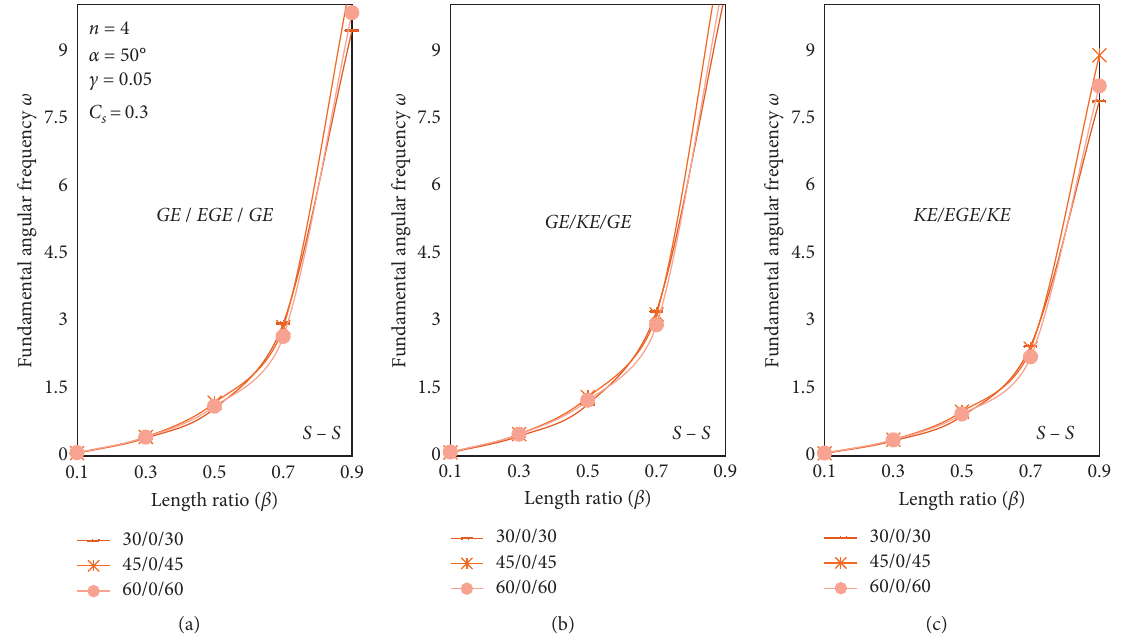
Figure 8: Influence of length ratio on the fundamental angular frequency of three-layered conical shells with different material combinations.